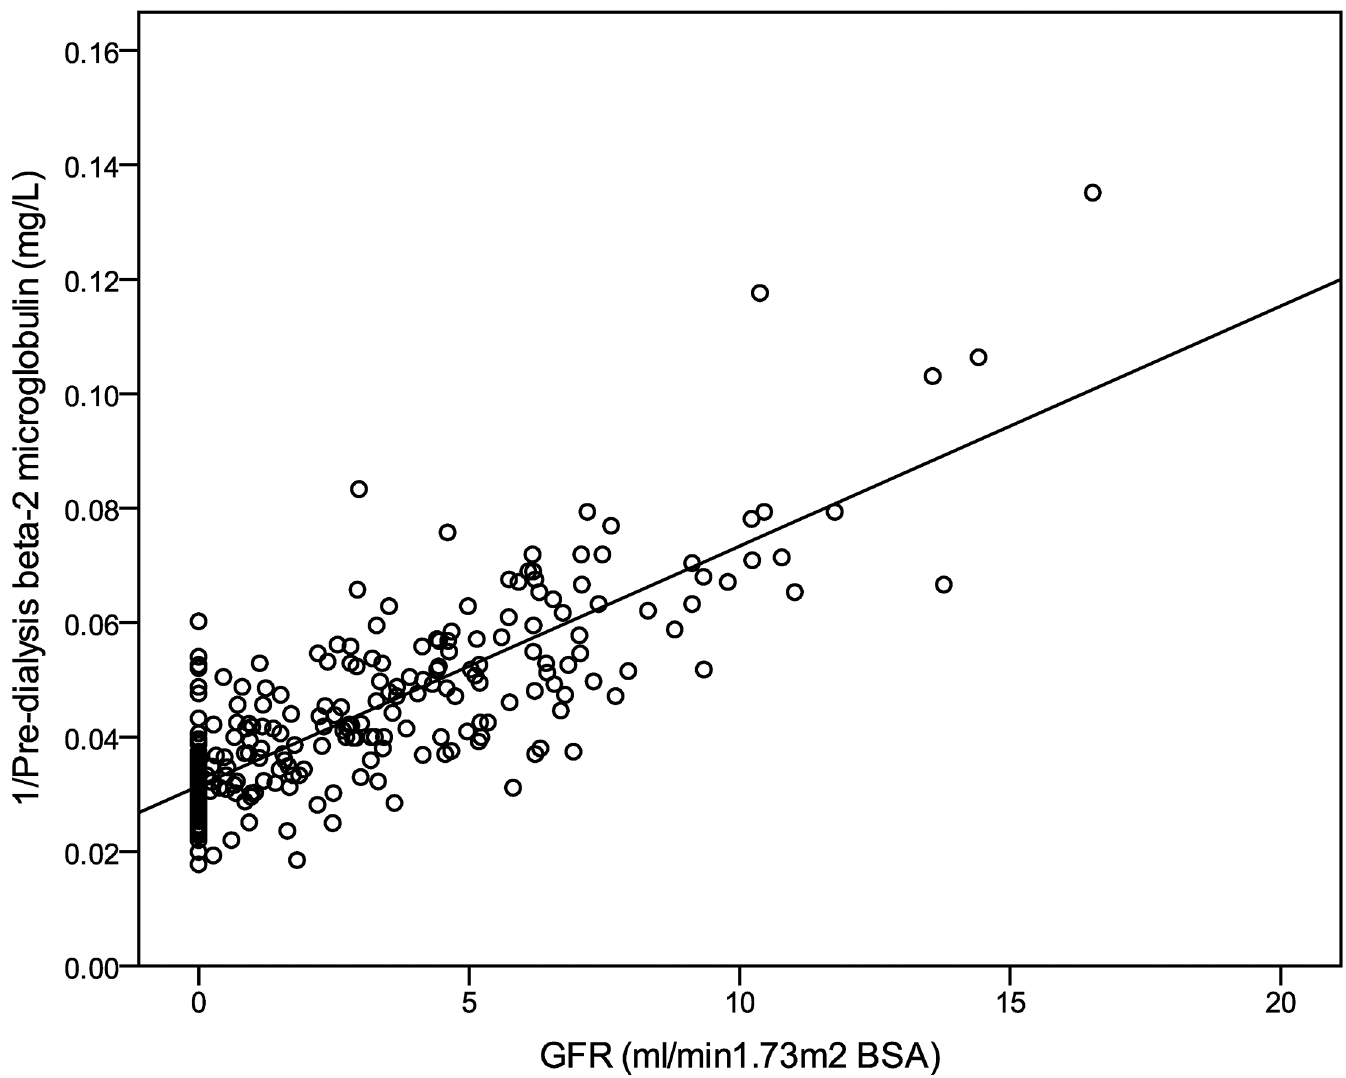
Fig 1. Relationship of GFR with the reciprocal of pre-dialysis β 2 microglobulin levels. GFR shown is calculated from mean of urea and creatinine clearance. For the linear regression shown r2 was 0.67. doi:10.1371/journal.pone.0143813.g001 of (cid:5) 16.3 mg/L had 100% sensitivity and 90% specificity (Table 5). Likewise a cut-off of (cid:5) 16.7mg/L identified patients with a GFR (cid:4) 10 ml/min/1.73m 2 BSA with similar levels of sen-